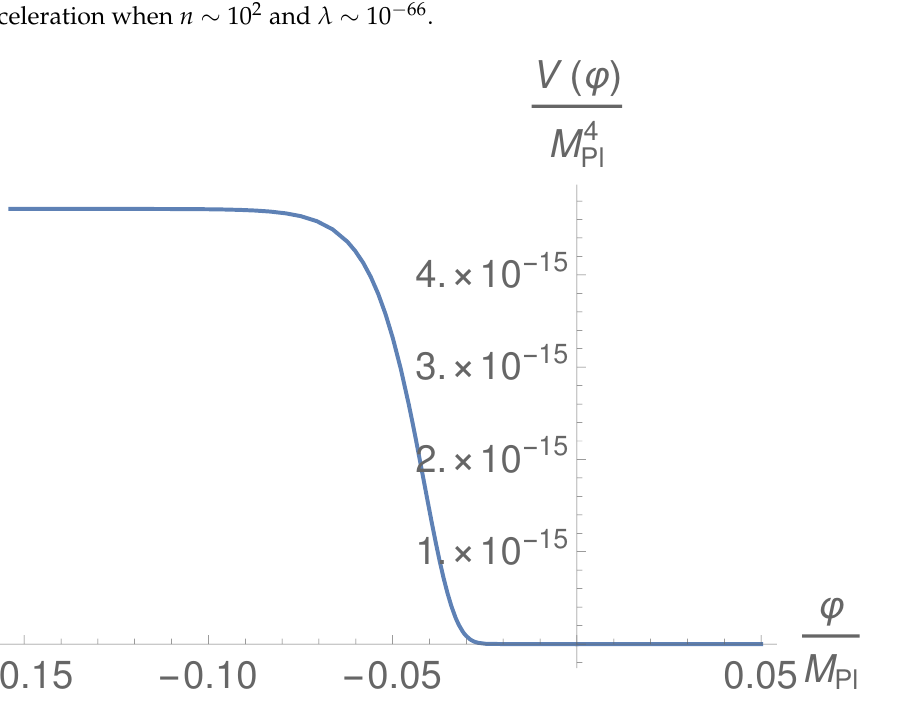
Figure 1. The α -attractor potential. In Lorentzian QI, the corresponding potential has a similar